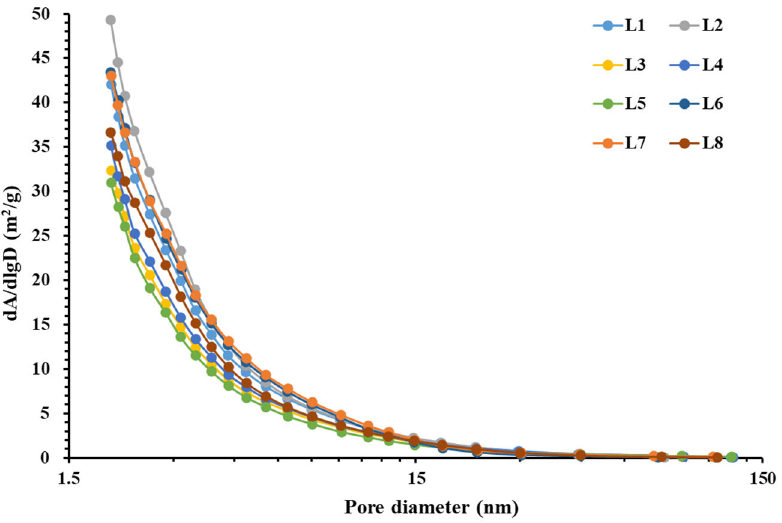
Figure 12. The distribution curve of the specific surface area of deep shale measured by LPNA.